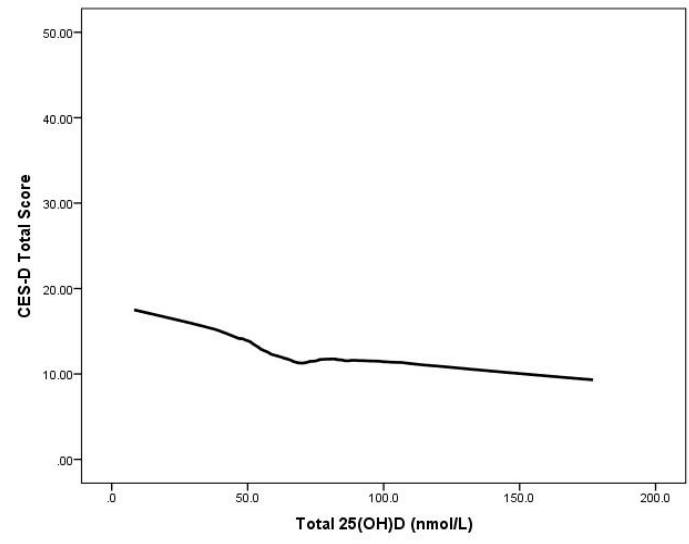
Figure 1. CES-D scores by serum 25(OH)D concentration in 615 young adults aged 17–25 years: LOWESS plot.